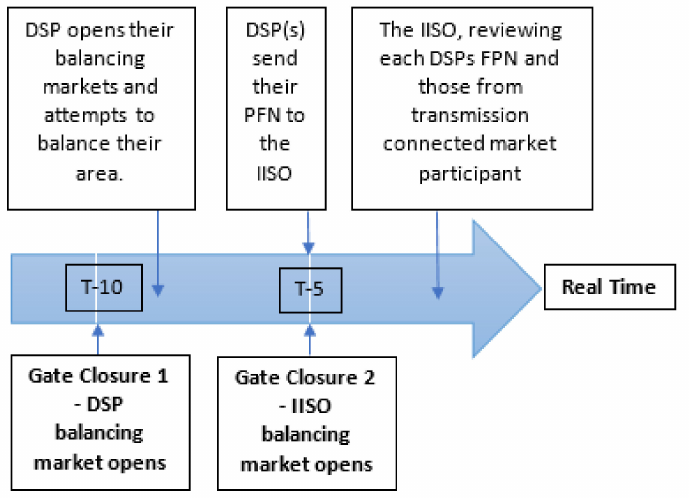
Figure 2. Proposed timeline of events illustrating the two-gate closure process. Authors’ own. By providing an overview of the entire network to the IISO, it may indicate how the culmination of imbalances from DSP regions, and deviations from the contracted positions of transmission-connected market participants may in fact ‘net off’, reducing the need for balancing actions. This knowledge would not be known by individual DSPs, justifying the IISO receiving all FPN and implementing any remaining balancing